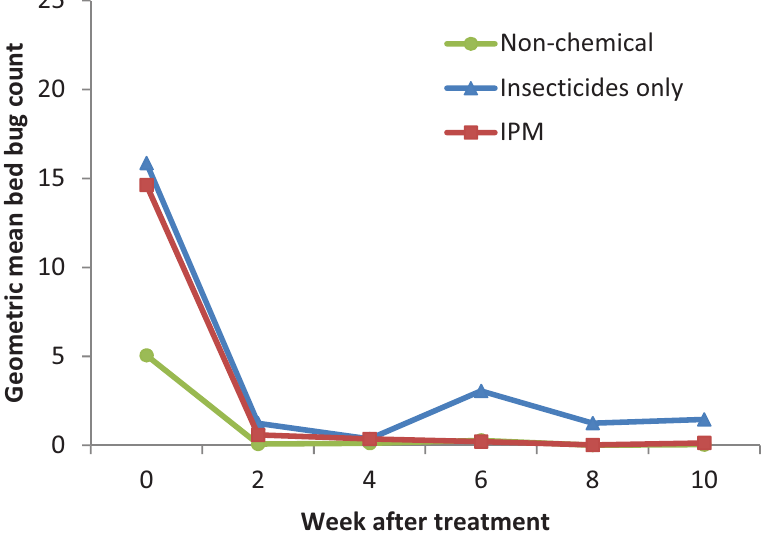
Figure 1. Effectiveness of three bed bug management strategies on bed bug